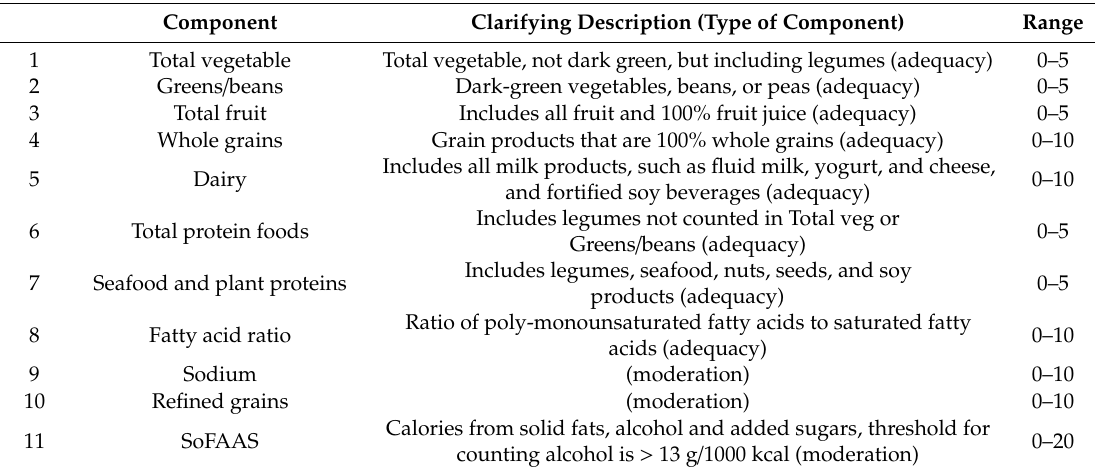
Table 1. HEI-2010 components used in the latent class analysis approach with description, type of component and maximum score